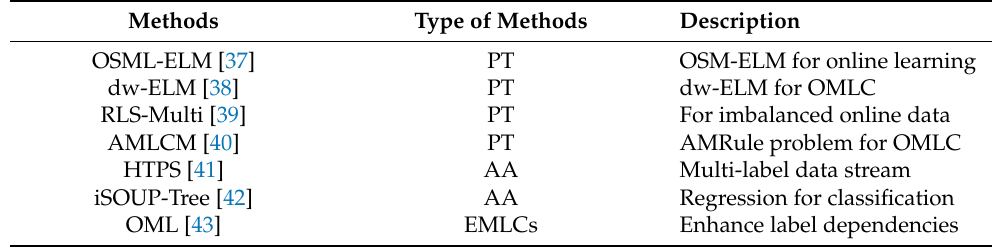
Table 1. Online Multi-Label Classification